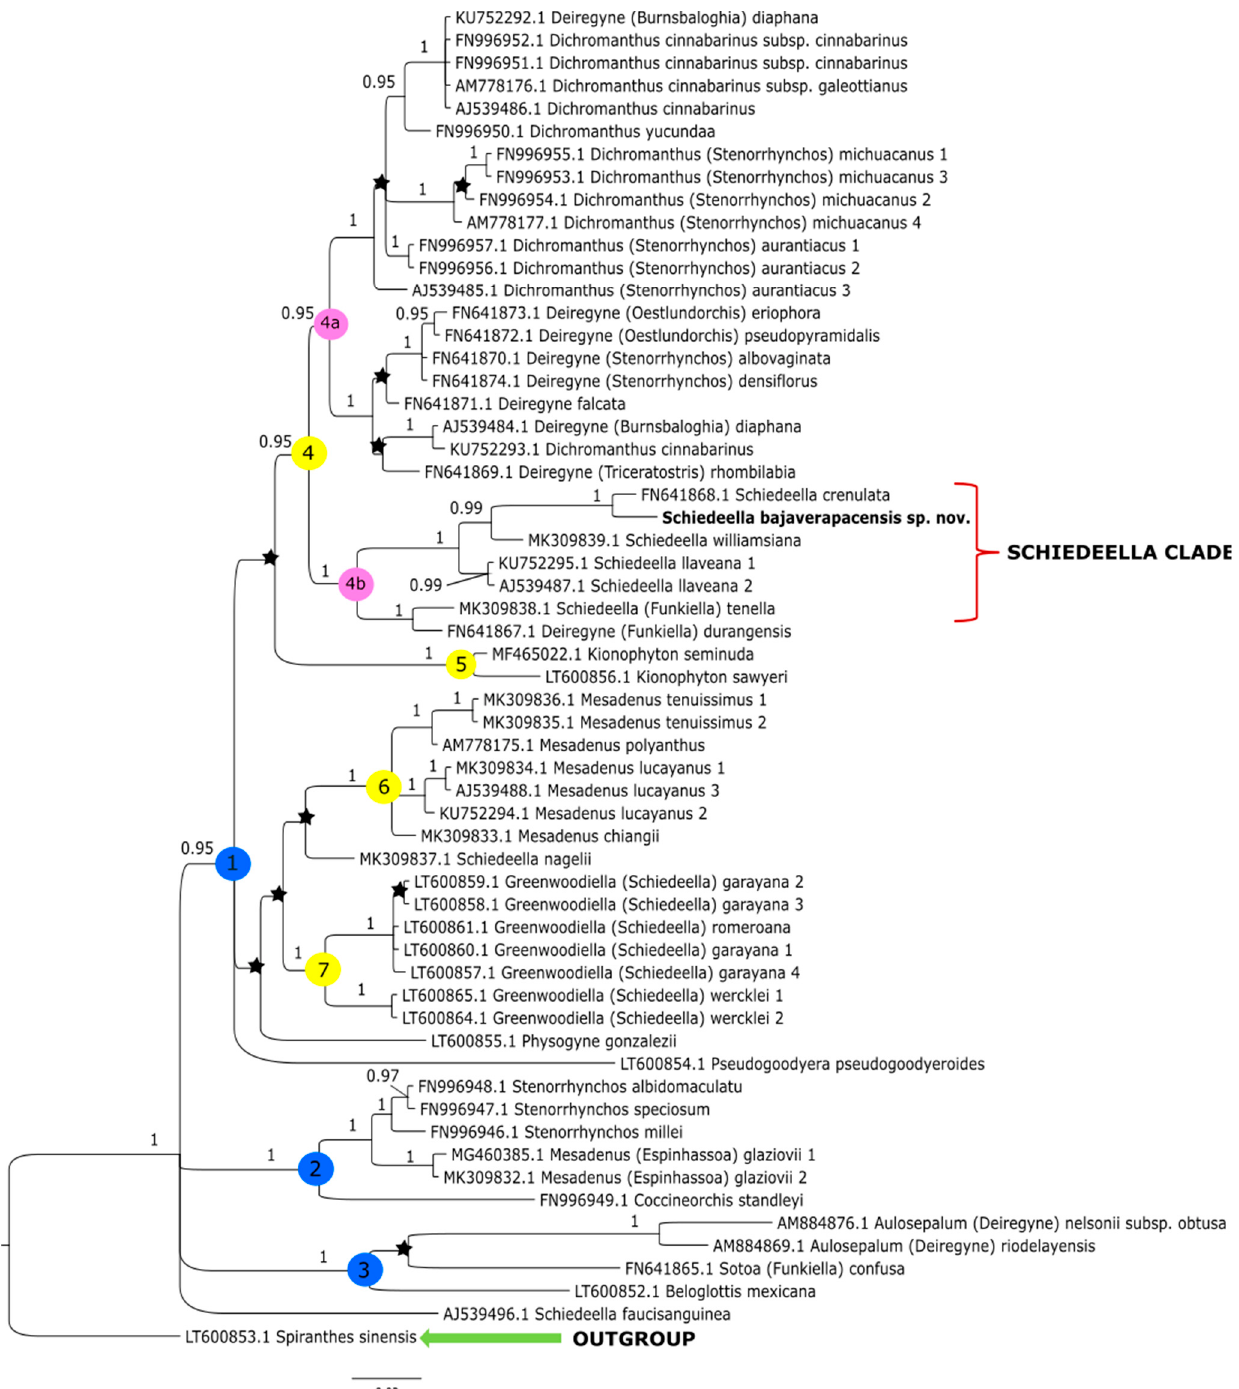
Figure 2. The phylogenetic tree presenting the position of Schiedeella bajaverapacensis sp. nov., obtained for the ITS1-5.8S-ITS2 region based on BI analysis. Posterior probability (PP) values are indicated above the branches and PP < 0.95 as an asterisk. While the numbers marked in circles on the nodes mean discussed clades.